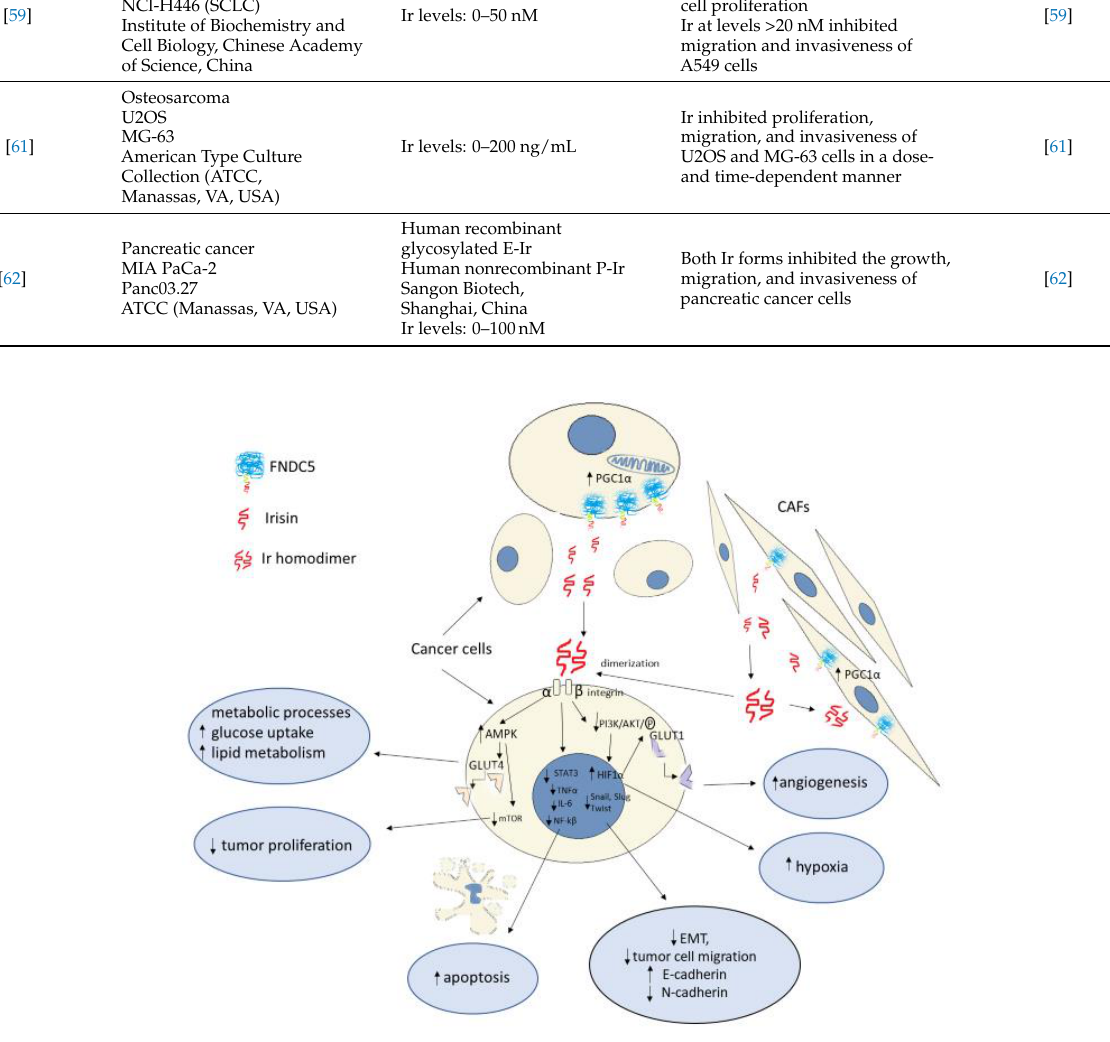
Figure 2. Potential roles of Irisin (Ir) in different signaling pathways and molecular processes involved in cancer progression, proliferation, angiogenesis, apoptosis, hypoxia, metabolic changes, and epithelial–mesenchymal transition (EMT) and migration of cancer cells. Ir has been observed in cancer cells and is also expressed in cancer-associated fibroblasts. This protein is cleaved from FNDC5 prohormone and has the potential to affect the neighboring cells (paracrine) or the cells from which it has been released (autocrine). Ir dimerizes and creates a homodimer with a beta sheet positioned be- tween monomers and binds as a ligand to the integrin receptor. Ir binding to the receptor can affect many signaling path- ways. Ir inhibits proliferation via the AMPK–mTOR pathway and increases glucose uptake via GLUT4 incorporation into the cell membrane. Ir affects the STAT3/Snail pathway, inhibits IL-6, and reverses EMT. Ir decreases the expression of N- cadherin and increases the expression of E-cadherin. Snail is downregulated by Ir via decreased phosphorylation of PI3K/Akt. Table 1. Summary of the results of Irisin levels in in vitro model studies.